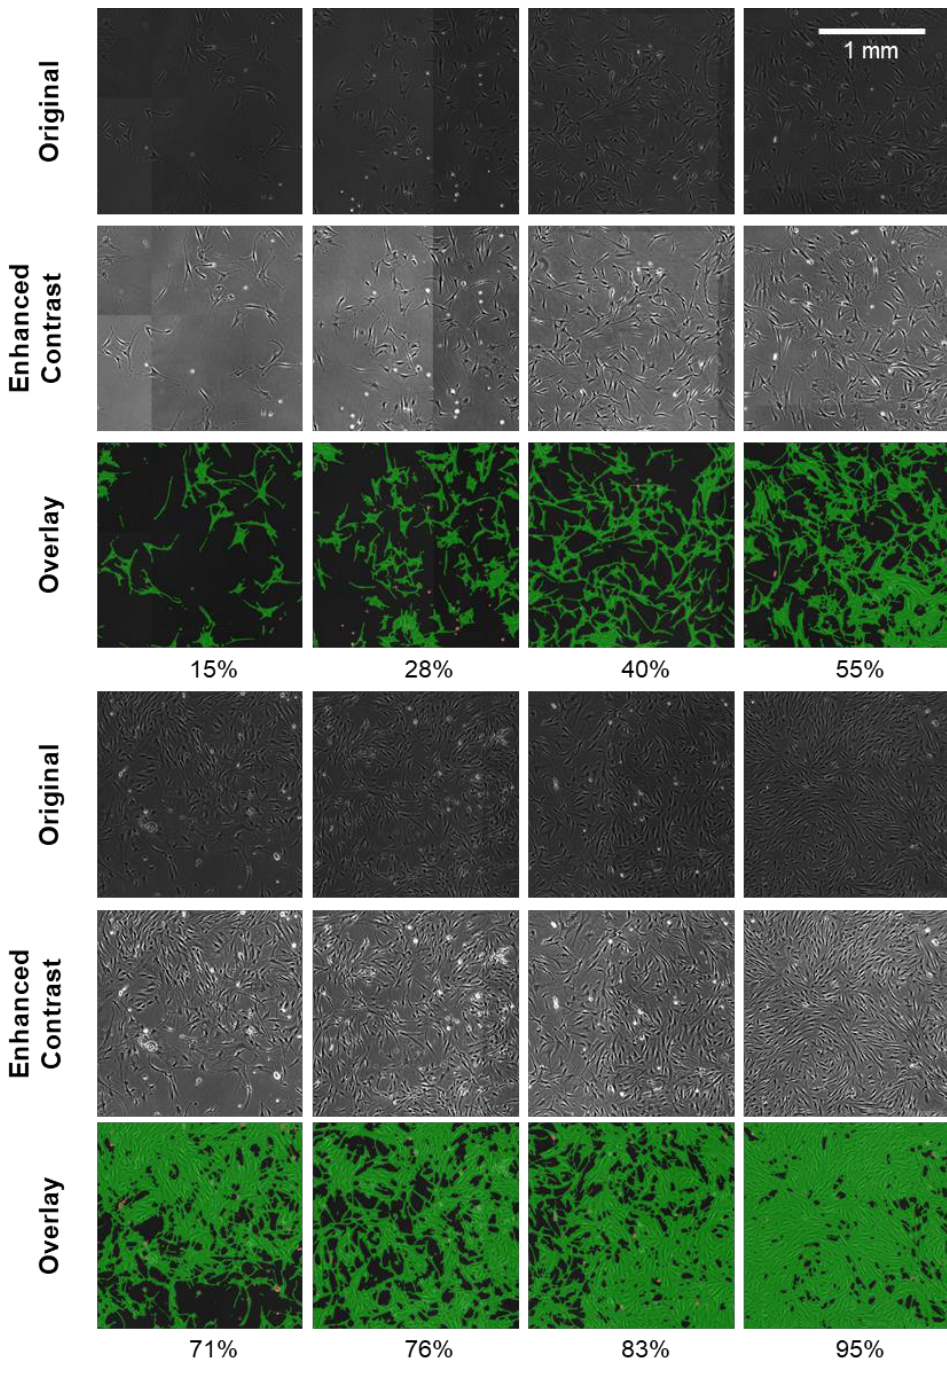
Figure 5. Overlay of selected microscope images at different densities taken during the cell culture of human adipose-derived mesenchymal stem cells (hMSC) from the two donors. Top row: section of the original microscopic image captured using phase contrast. Middle row: microscopic image with enhanced contrast for easier comparison. Bottom row: overlay of the image map from the confluence algorithm (green) with the original microscopic image. Below each column, the calculated confluence of the image is given.